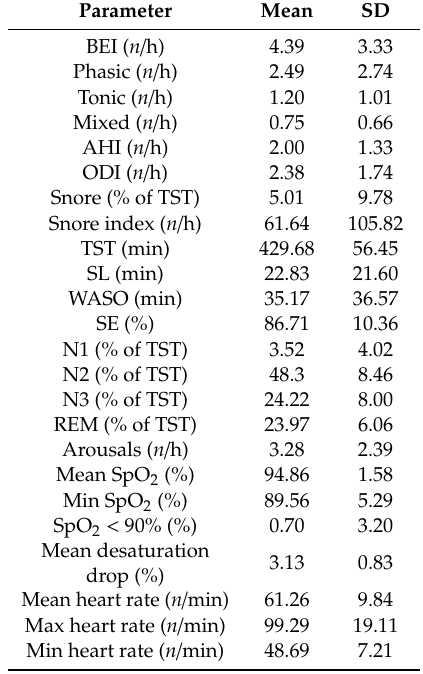
Table 1. Bruxism and respiratory parameters—polysomnographic characteristics of the study group.